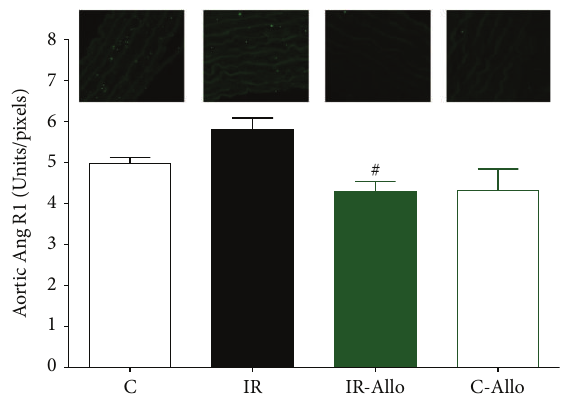
Figure 7: The effect of allopurinol (Allo) treatment on insulin resistance (IR) induced Ang R1 changes, measured in Units/pixels. Values are expressed as the mean ± SEM; 𝑁 = 6 – 8 animals; # 𝑃 < 0.05 compared with thecorresponding IRgroup values, by One-Way ANOVA and Newman-Keuls post hoc test.